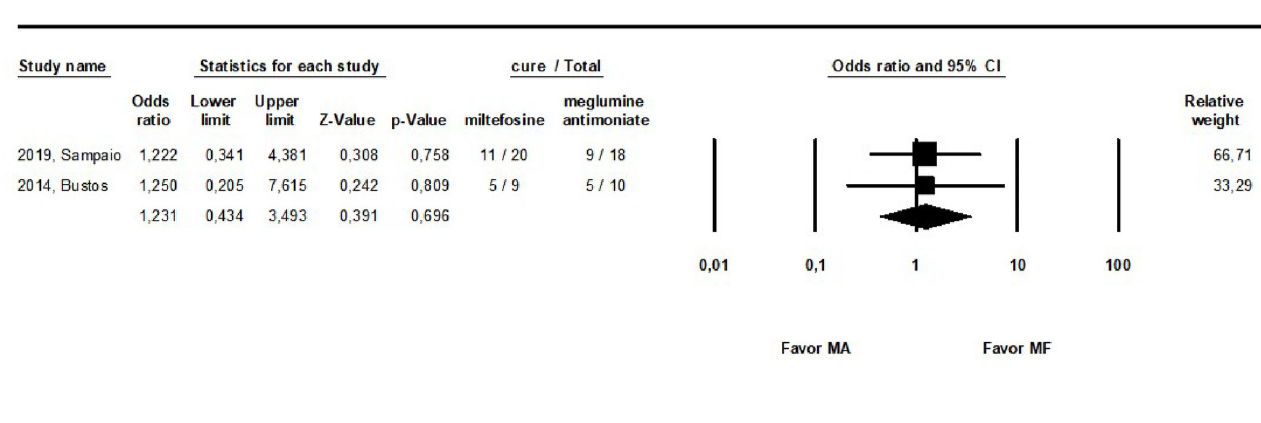
Fig 9. Meta-analyzis of studies directly comparing meglumine antimoniate and miltefosine for the treatment of ML.